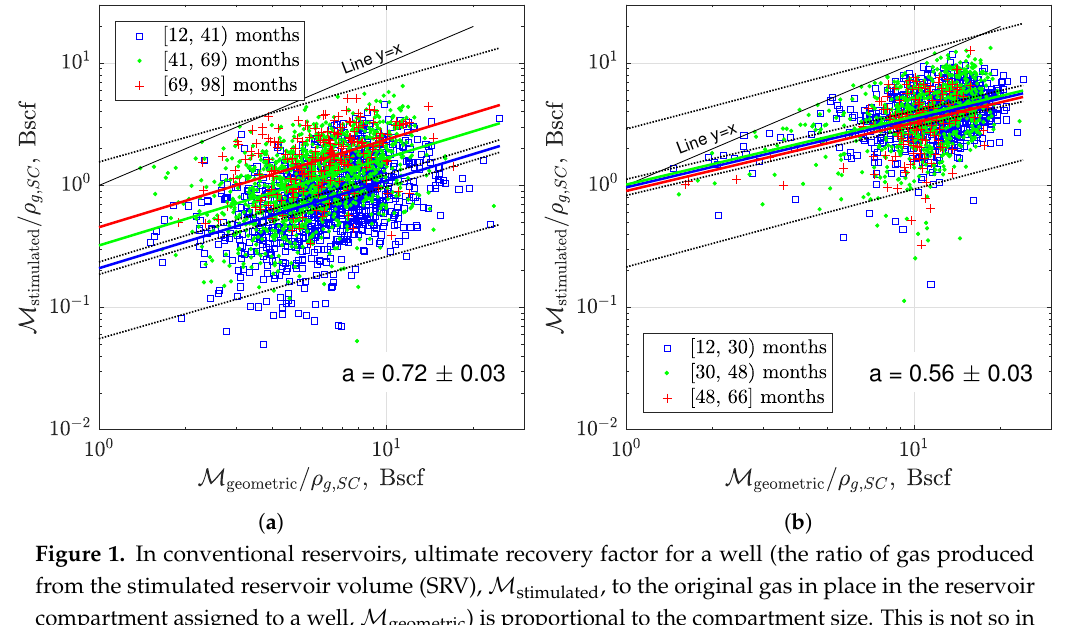
Figure 1. In conventional reservoirs, ultimate recovery factor for a well (the ratio of gas produced from the stimulated reservoir volume (SRV), M stimulated , to the original gas in place in the reservoir compartment assigned to a well, M geometric ) is proportional to the compartment size. This is not so in mudrock reservoirs, where produced gas is only partially connected to the reservoir compartment. In this case, produced gas volume is proportional to the compartment size raised to a fractional (fractal) power exponent a < 1. The weaker is the mudrock connectivity, the smaller is the exponent. ( a ) The power law scaling for three intervals of times on production (three age groups) of Barnett shale wells with the ages shown in the legend. The three solid lines are the result of a joint linear regression of production from these three groups of wells. The 95% CI that the regression explains the linear trend in the blue data points are drawn as the dotted lines above and below the blue fit. The 95% CI that a new well will belong to the blue dataset is shown as the outer dotted lines. The single power law exponent a = 0.72 explains all data. ( b ) The corresponding three linear trends for Haynesville almost overlay one another. Most of the poorest producers are on the Texas side of the play. Notice that the power exponent explaining gas production from the Haynesville wells a = 0.56 is smaller than that in Barnett. Hence, on average, SRV connectivity in Haynesville is weaker than that in